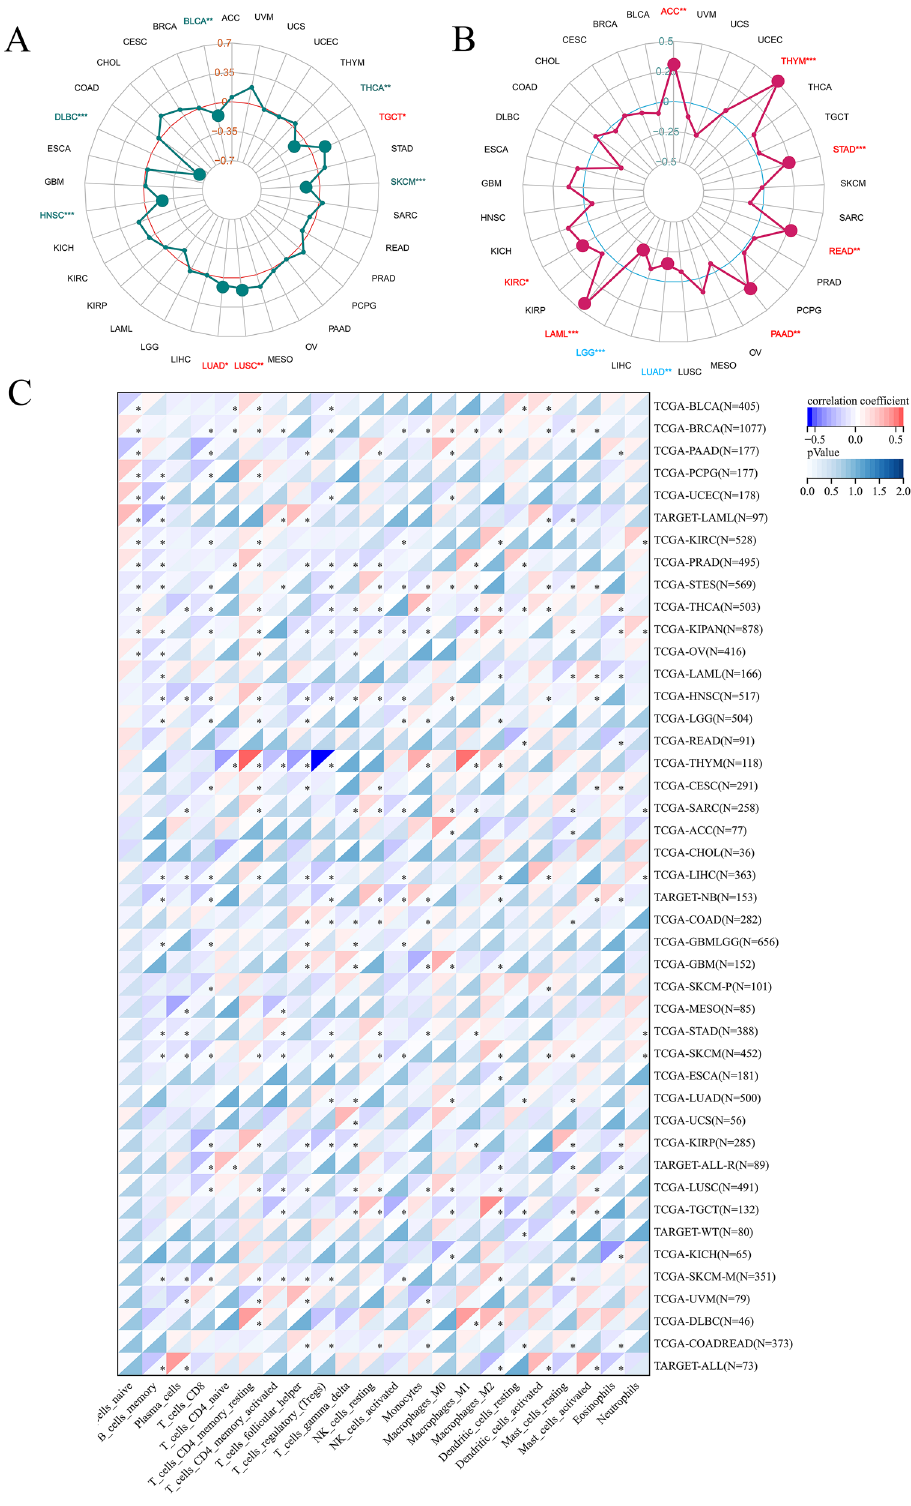
Figure 5. FAT1 correlates with MSI, TMB, and immune in pan-cancer. ( A ) Correlation of FAT1 expression with pan-cancer MSI. ( B ) Correlation between FAT1 expression and pan-cancer TMB. ( C ) Correlation of FAT1 expression with the amount of pan-cancer immune cell